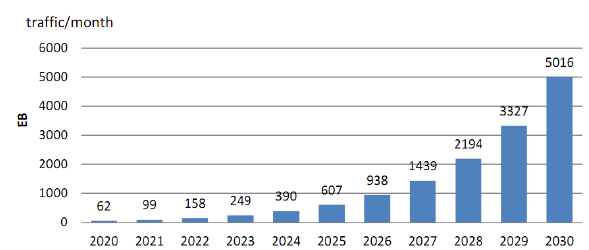
Figure 1. Estimations of global mobile traffic in 2020-2030